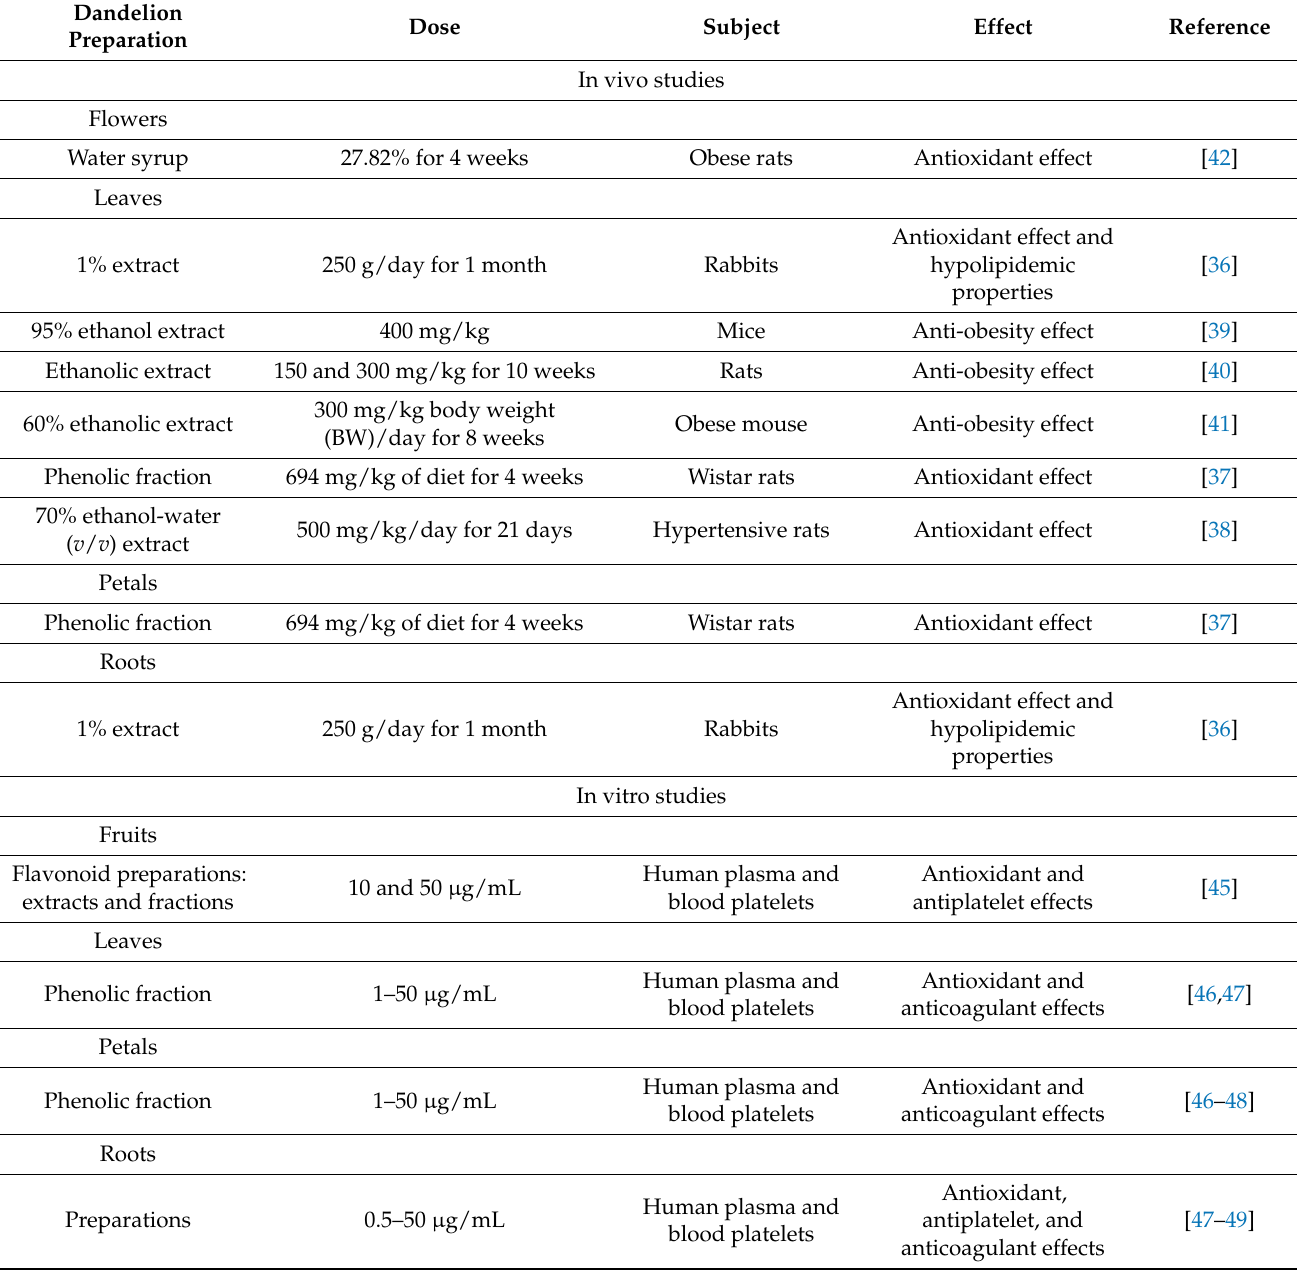
Table 1. Effect of dandelion preparations on the cardiovascular system and its diseases (in vivo and in vitro